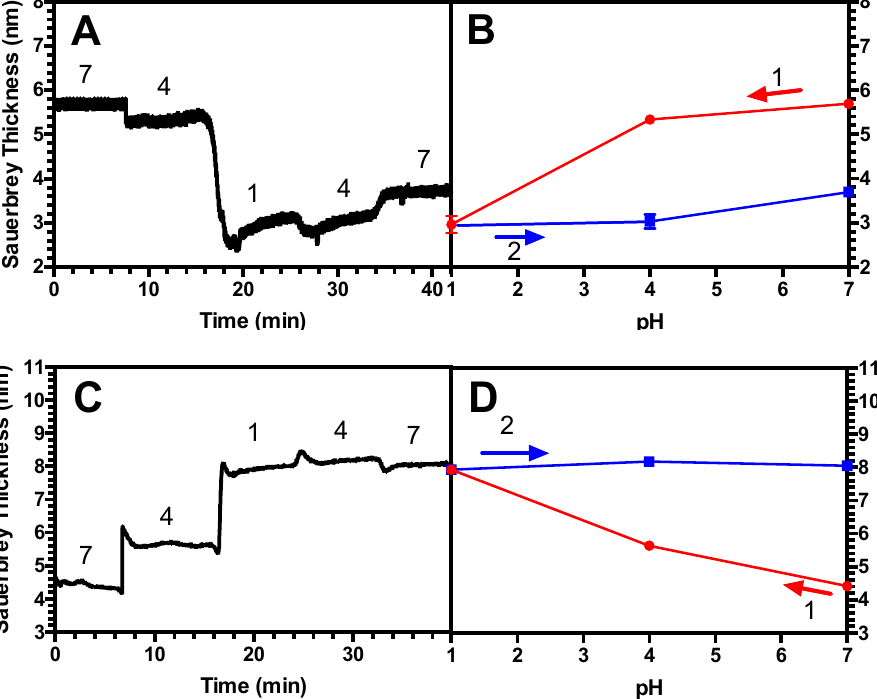
Figure 4. ( A – D ) are The same as in Figure 2, except for a grafting density σ = 0.023 in 100 mM Figure 4. ( A–D ) are The same as in Figure 2, except for a grafting density (cid:2026) = 0.023 in 100 mM KCl. Thus, a dilute-grafted long-chain PAA brush and its corresponding (PAA/PEI) bi- layer show hysteresis, while the densely grafted long-chain brush shows no measurable hysteresis, although its (PAA/PEI) bilayer does. To examine more precisely this transition to hysteretic behavior in long-chain, sparsely grafted brushes, we investigate a chain of intermediate length, 14 kDa, and grafting density, (cid:2026) = 0.06 chains/nm 2 . Figure 5A shows that this brush, when subjected to a pH sweep, only slowly approaches a steady state, and as a result, only 3, rather than 4, different pH values were investigated. Despite the slow- ness of equilibration, Figure 5B shows that the brush de-swells with decreased pH as be- fore, and when pH is increased again, does appear to approach its original height at each pH over an extended timescale. Figure 5B shows that, unlike the long-chain, dilute brush of Figure 3A,B, the intermediate-length brush at long times is not appreciably hysteretic; the error bars are comparable in size to the hysteretic gap in thicknesses. This medium- chain brush, when equilibrated with PEI of similar chain length to form a (PAA/PEI) bi- layer, had a dry thickness of 1.70 nm compared to the 1.29 nm dry thickness of the PAA underlayer alone. In Figure 5C, it can be seen that the bilayer swelling is nearly, but not quite as, reversible when subjected to a reversing pH sweep, as the monolayer brush is, in Figure 5A. While the result in Figure 5D suggests some hysteresis, again, it is difficult to be sure due to the limited size of our sample (N = 3) and the magnitude of the error bars. Table 2 summarizes the hystereses for all PAA brushes and complementary bilayers.